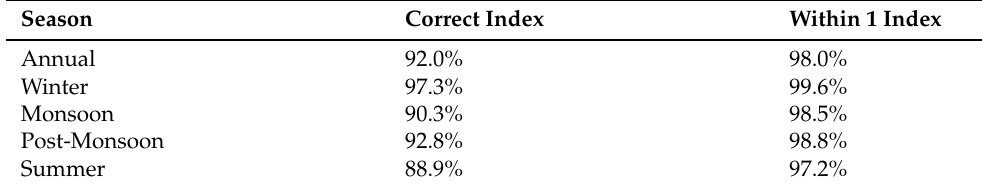
Figure 18. Air quality index categories for ozone [64]. Table 8. Percent time each index is correctly predicted in exactly the right air quality index, and within one index, using the XGBoost